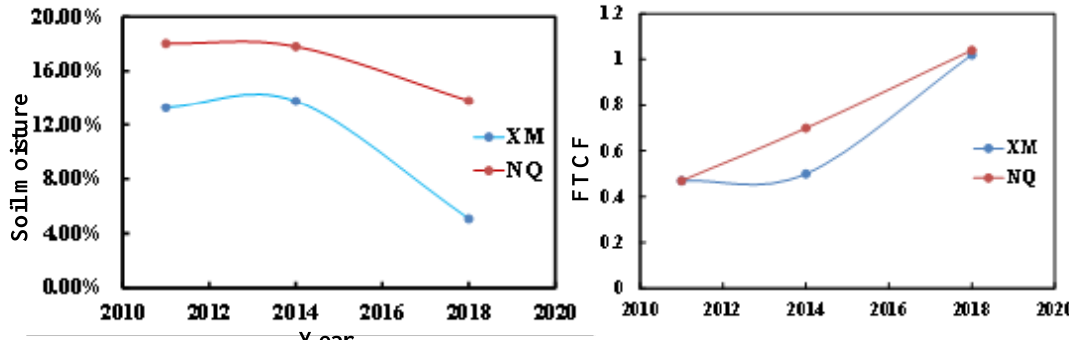
Figure 8. The changes in soil moisture and the FTCF in XM and NQ in 2011, 2014, and 2018.